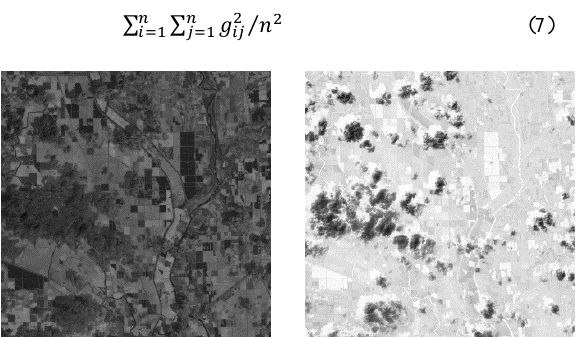
Figure 4 . Dataset I : California, USA.